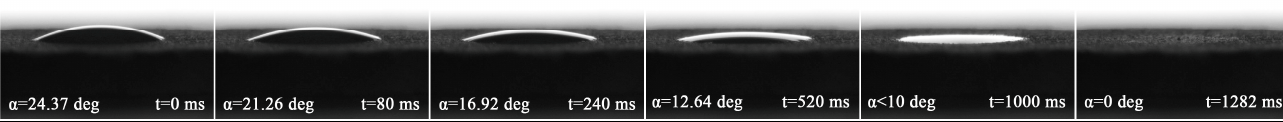
Scheme 1. Sequential photo frames cut out from the video film of the droplet behaviour on the surface of a 16% kaolinite–silt pellet.